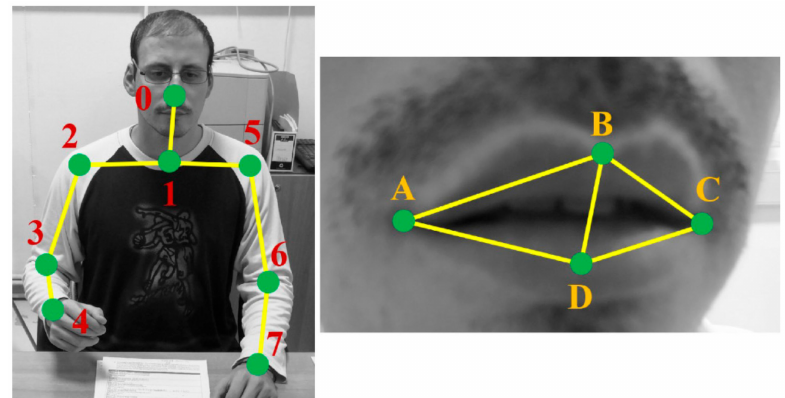
Figure 5. Schematic representation on a researcher of the skeletal joint (0–7) and mouth (A–D) points tracked and analyzed in the RABiD algorithm. Both two-dimensional (2D) coordinates and distances are analyzed over the meal